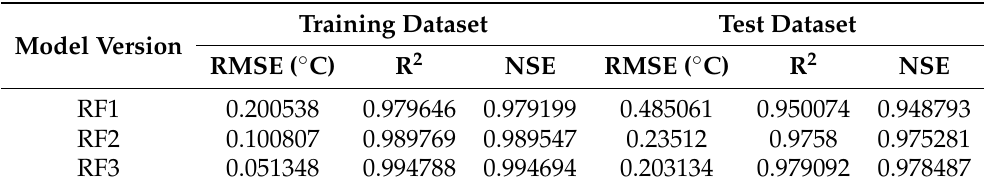
Figure 8. Model fitting results—RandomForest Regressor, blue dot: X coordinate (observed data), Y coordinate (predicted data) ; black line: y = x ; red dotted line: the regression curve of the blue dots. ( a ) only one input variable (DOY), ( b ) with two input variables (DOY and Flow), ( c ) with all variables. Table 3. Performances of RandomForest Regressor in modeling water temperature (WT: ◦ C), RF1: only one input variable (DOY), RF2: with two input variables (DOY and Flow), RF3: with all input